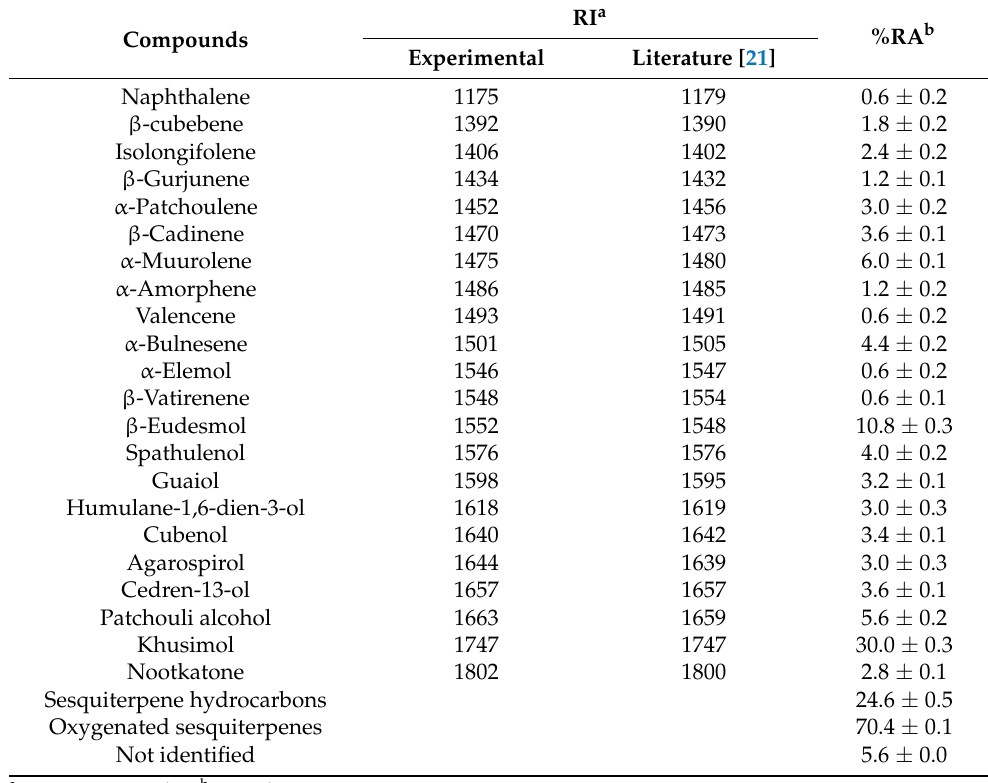
Table 1. CZ-EO chemical composition, as determined by GC-FID and GC-MS.